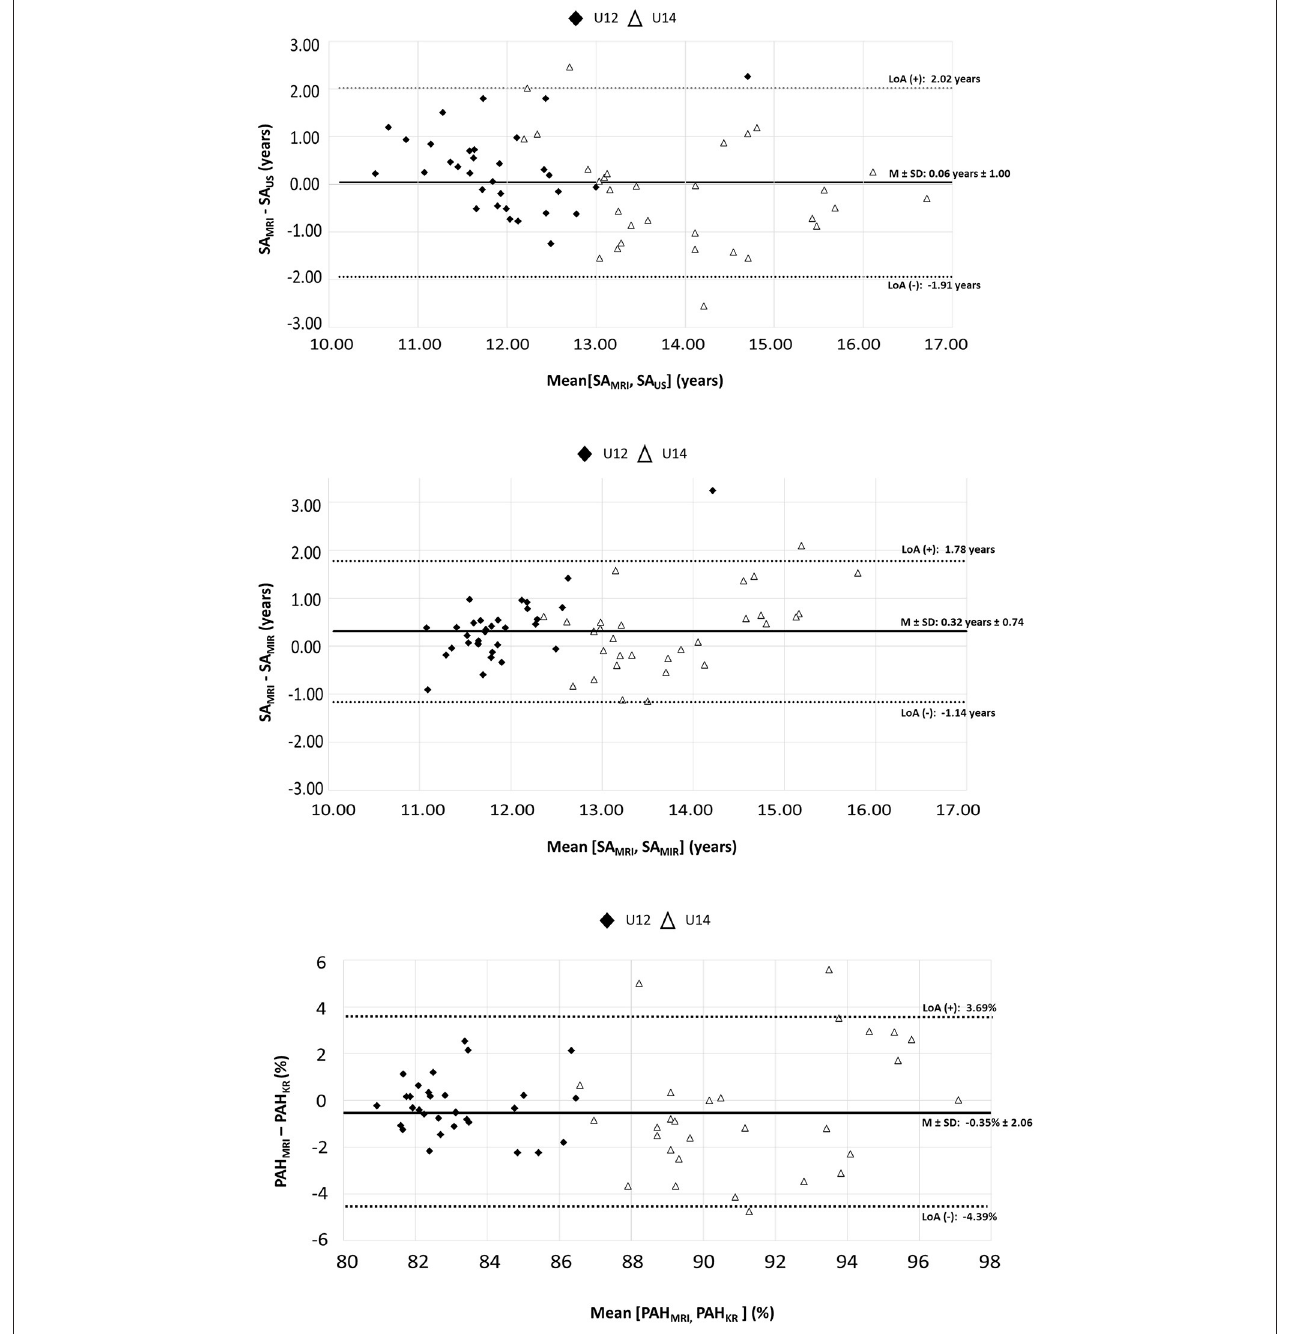
FIGURE 2 | Bland–Altman plots: individual differences of SA MRI and the alternative BMS diagnostics. SA MRI , skeletal age determined by magnetic resonance imaging; SA US , skeletal age determined by mobile ultrasound device; SA MIR , maturity offset (Mirwald et al., 2002) transformed to skeletal age according to Thodberg et al. (2009); PAH KR , percentage of adult height according to Khamis and Roche (1994); PAH MRI , skeletal age determined by magnetic resonance imaging converted to percentage of adult height according to Thodberg et al.